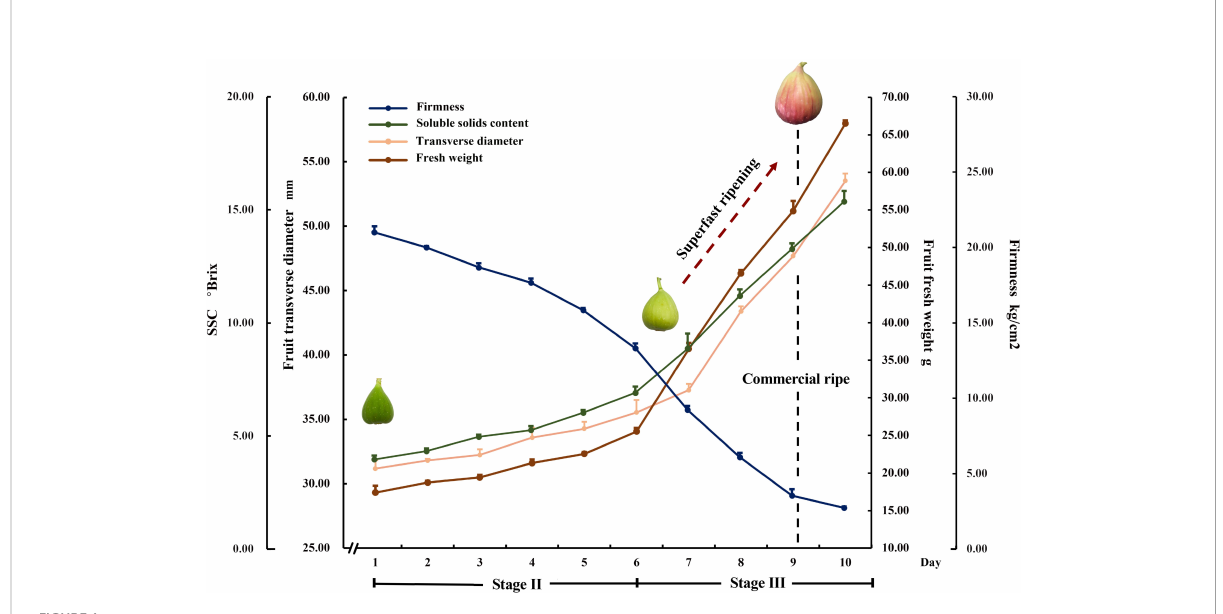
FIGURE 1 Superfast ripening in fi g